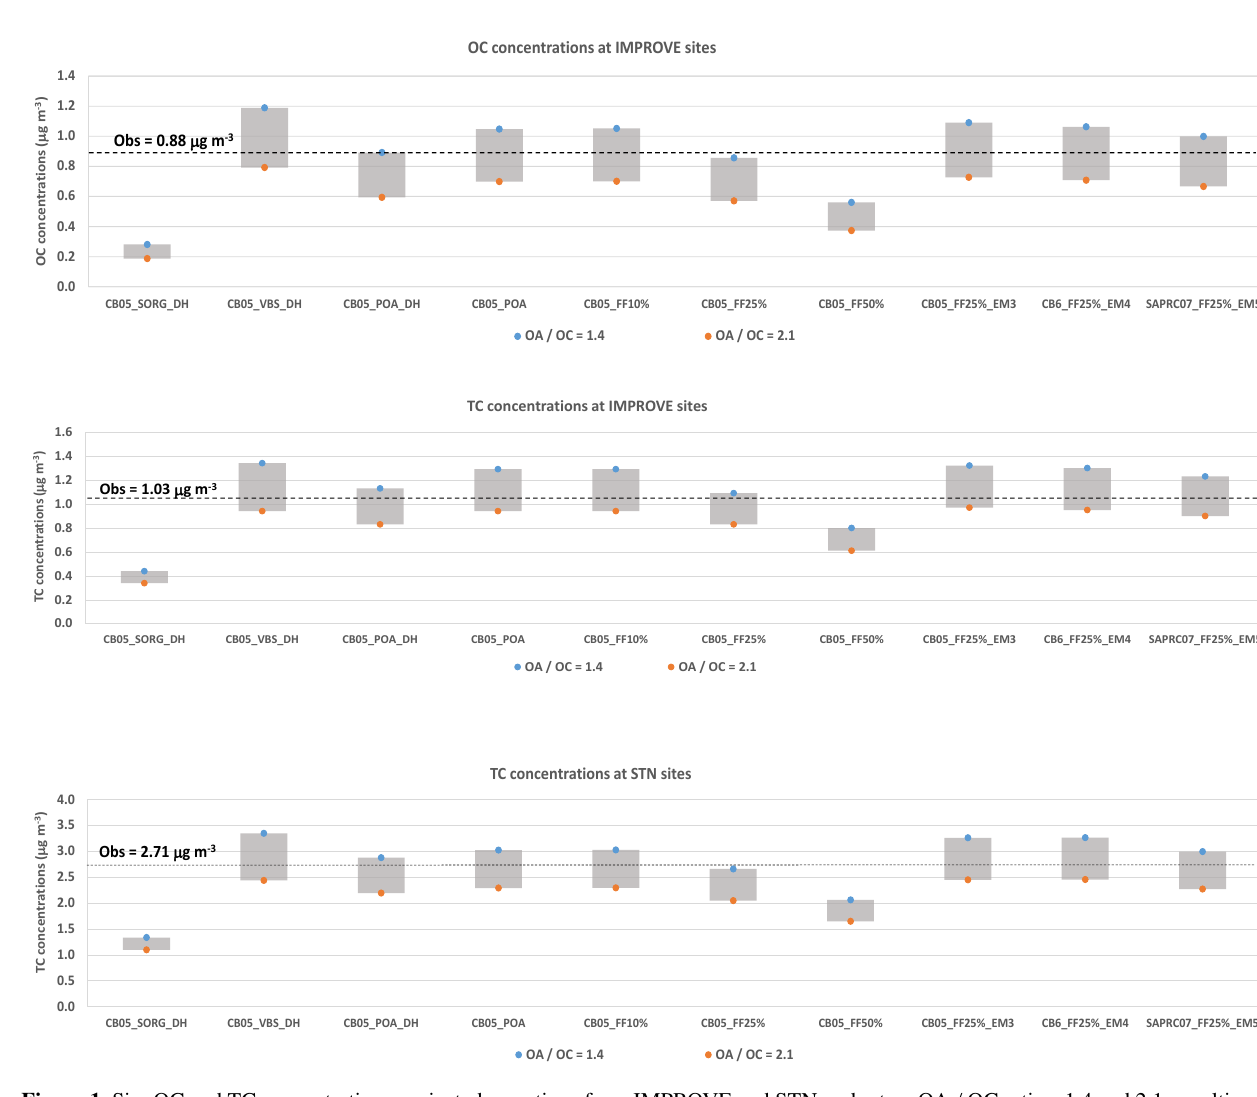
NMEs and the lowest Corr compared to all other simula- tions with a SOA module based on the VBS method. The remaining VBS simulations significantly reduce the biases and errors in OC and TC from CB05_SORG_DH and also improve the correlation. Compared to CB05_SORG_DH, CB05_VBS_DH with nonvolatile POA seems to perform rel- atively well in terms of NMBs and Corr against IMPROVE OC, IMPROVE TC, and STN